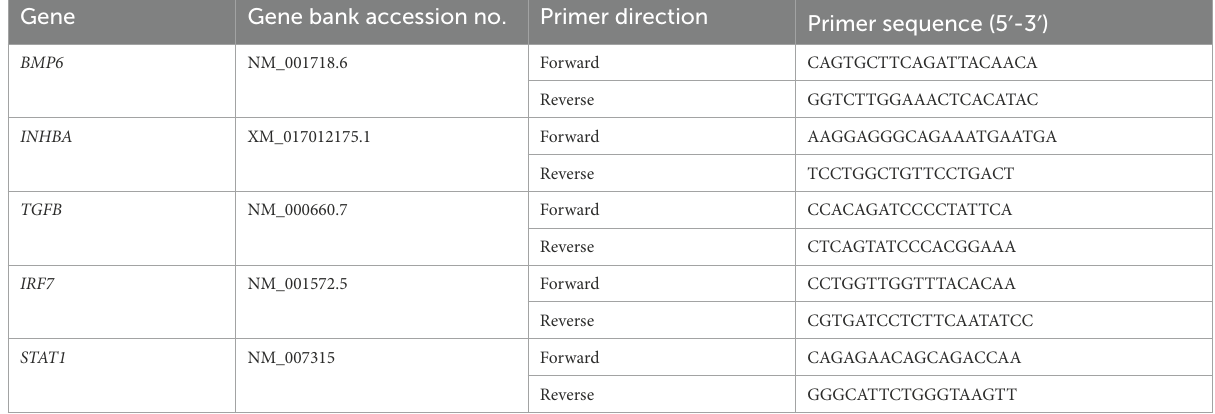
TABLE 1 Primer sequences used for